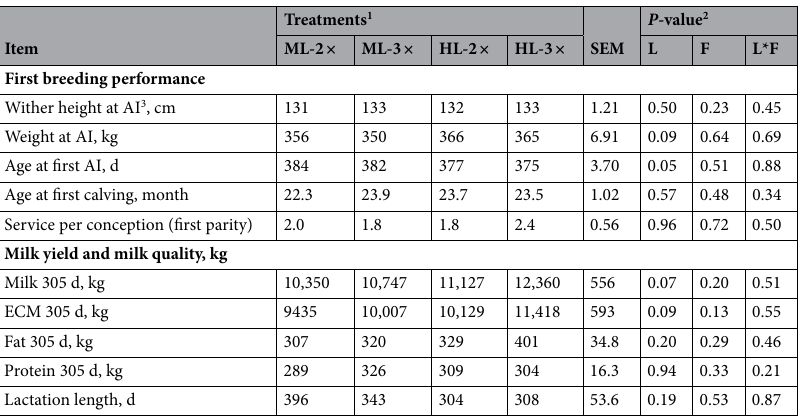
Table 6. Effects of milk feeding level (medium vs. high) and milk feeding frequency (2 vs. 3) on first breeding and first lactation of heifers. 1 Treatments including medium milk level- feeding 2 times (ML-2 ×), medium milk level- feeding 3 times (ML-3 ×), high milk level- feeding 2 times (HL-2 ×), and high milk level- feeding 3 times (HL-3 ×). 2 Statistical comparisons: L = feeding level; F = feeding frequency, L × F = feeding level × feeding frequency. 3 AI = Artificial